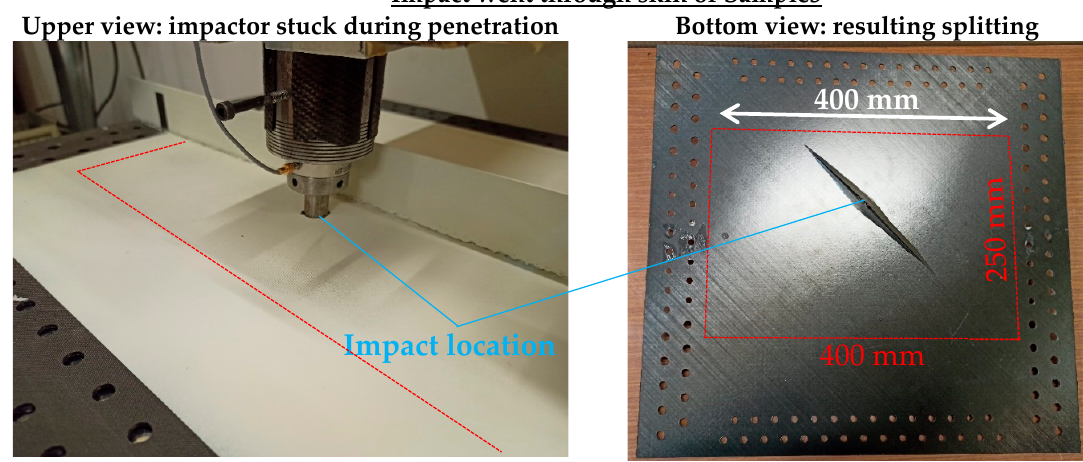
Figure 19. Pictures of the impact on Sample3: the impactor went through the skin, leaving a major splitting on the bottom face.